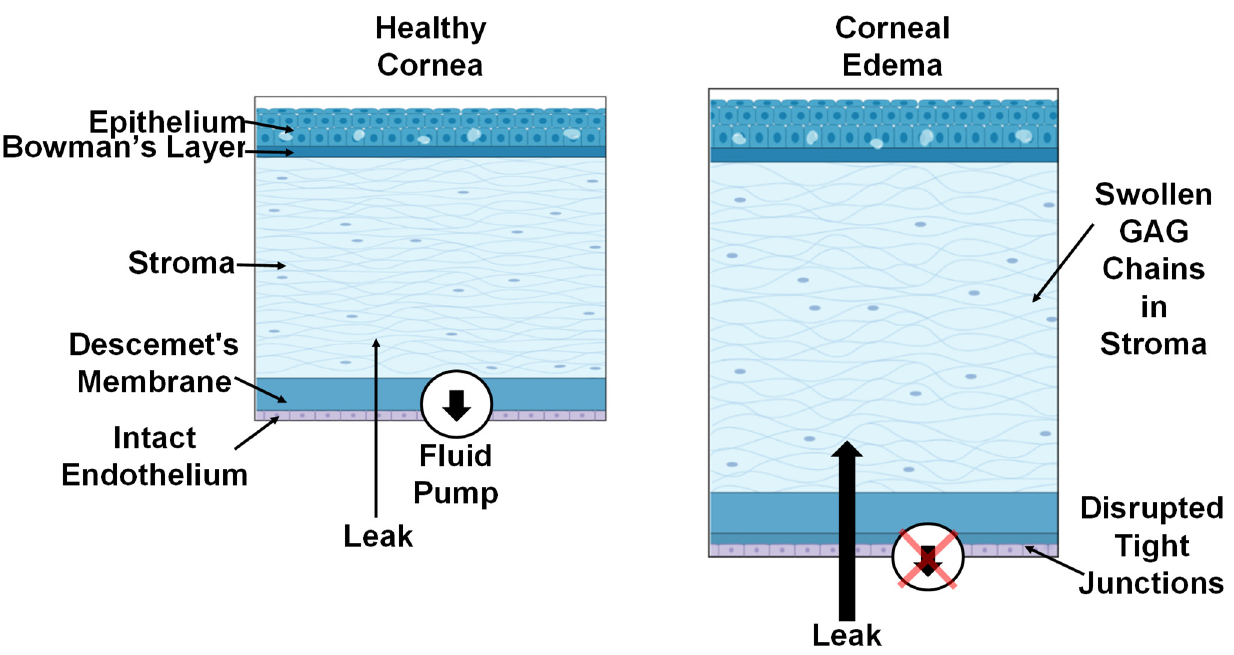
Figure 1. A schematic of two corneas with intact and damaged endothelial layers. The healthy cornea ( left ) is kept within a physiological range of thickness by the endothelial cells actively transporting excess fluid out of the tissue. The edematous cornea ( right ) is a result of the disrupted tight junctions and damaged fluid pump (red X) allowing more liquid into the tissue and inadequate transport of fluid out of the tissue. Images were generated using Biorender.io.